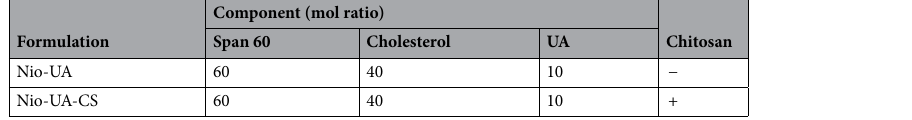
Table 3. Ursolic acid niosome formulation. UA ursolic acid, CS chitosan, ( −) without chitosan addition, ( +) with chitosan